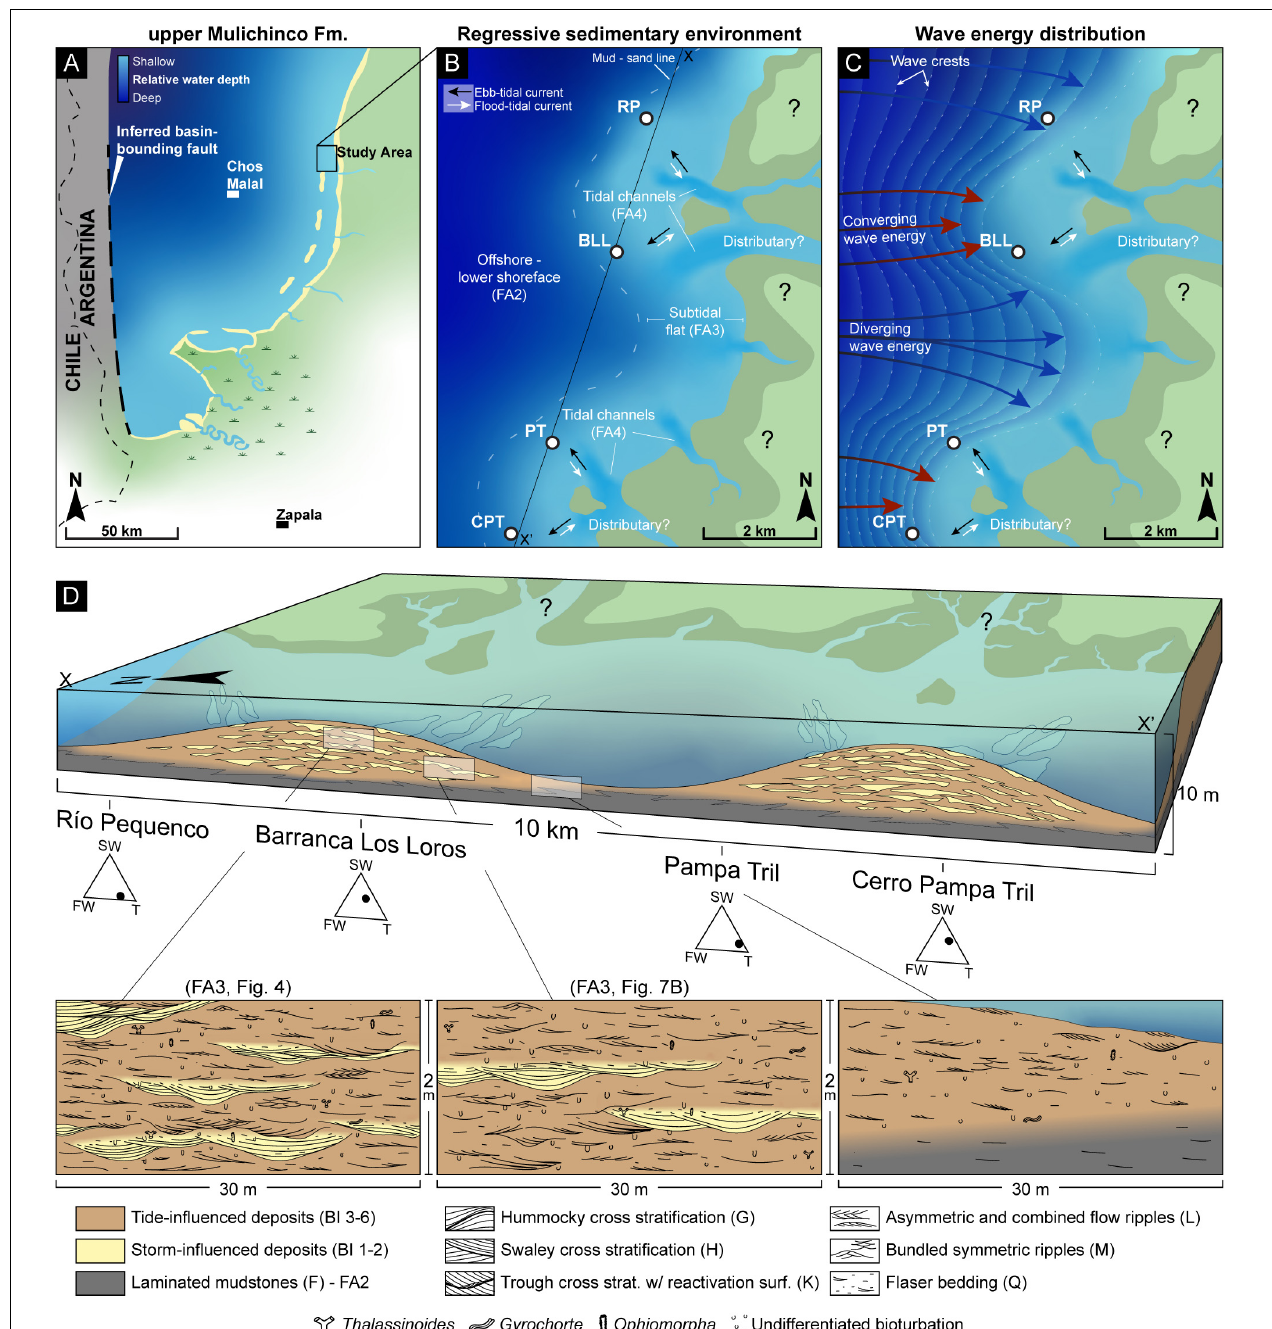
FIGURE 11 | (A) Paleogeographic reconstruction of the upper Mulichinco Fm. basin development, modified from Schwarz and Howell (2005; Figure 12f ); study area, cities, and national border are indicated. (B) Interpretation of sedimentary environment of the upper Mulichinco Fm. regressive development in the study area, based on the succession between FS5.2 and FS6 ( Figure 10 ), scale and localities indicated; absolute distance to shoreline not intended, and landward extent of depositional setting remains unknown. CPT, Cerro Pampa Tril; PT, Pampa Tril; BLL, Barranca Los Loros; RP, Río Pequenco ( Figure 1D ). (C) Storm wave refraction as explanation for the concentration of storm deposits at BLL and CPT localities, while limited or absent at PT and RP localities. (D) Block diagram showing distribution of storm- versus tide-influenced deposits of FA3, based on succession between FS5.2 and FS5.3 ( Figure 10 ); ternary diagram plots included for the portrayed FA3 succession (diagrams modified from Dashtgard et al., 2012), close-up views of representative sedimentary facies and observed architecture are from annotated figures, vertical scale is exaggerated, and absolute water depth and proximity to shoreline is not intended. See legend for facies and trace fossils; letters refer to Table 1 , BI, bioturbation